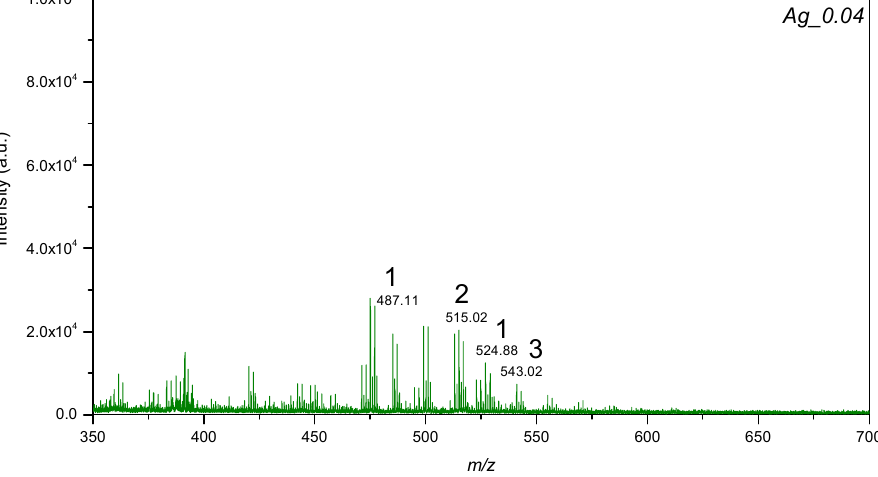
Figure 7. LDI-MS spectra of the standard mixture of lyso-phosphatidylcholines, where 1—15:0 LPC (25 µg/mL); 2—17:0 LPC (50 µg/mL); 3—19:0 LPC (25 µg/mL).